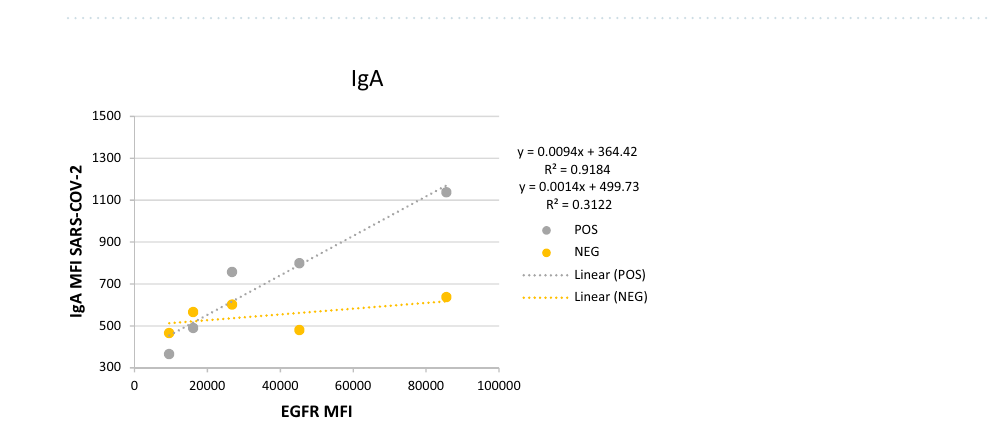
Figure 1. ( A ) IgG MFI of S-Jurkat (red) versus 0-Jurkat (green) cells in negative (1–50) and confirmed SARS- CoV-2 samples (51–100). ( B ) IgA MFI of S-Jurkat (red) versus 0-Jurkat (green) cells in negative (1–50) and confirmed SARS-CoV-2 samples (51–100). ( C ) MFI ratio of all analyzed samples.